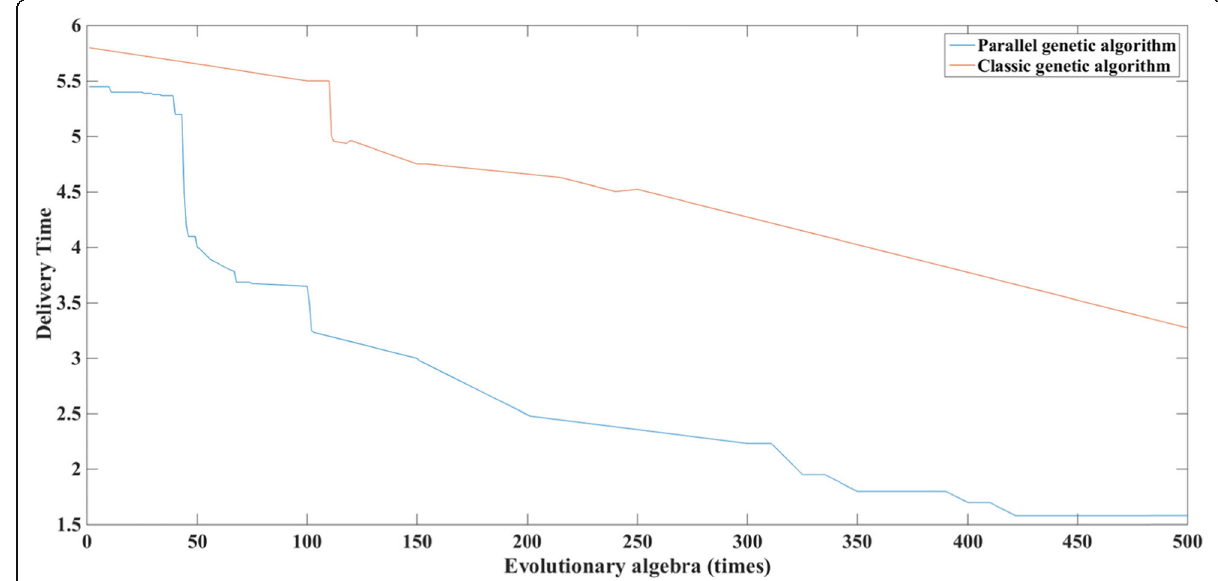
Fig. 7 Comparison of coarse-grained parallel genetic algorithm and classic genetic